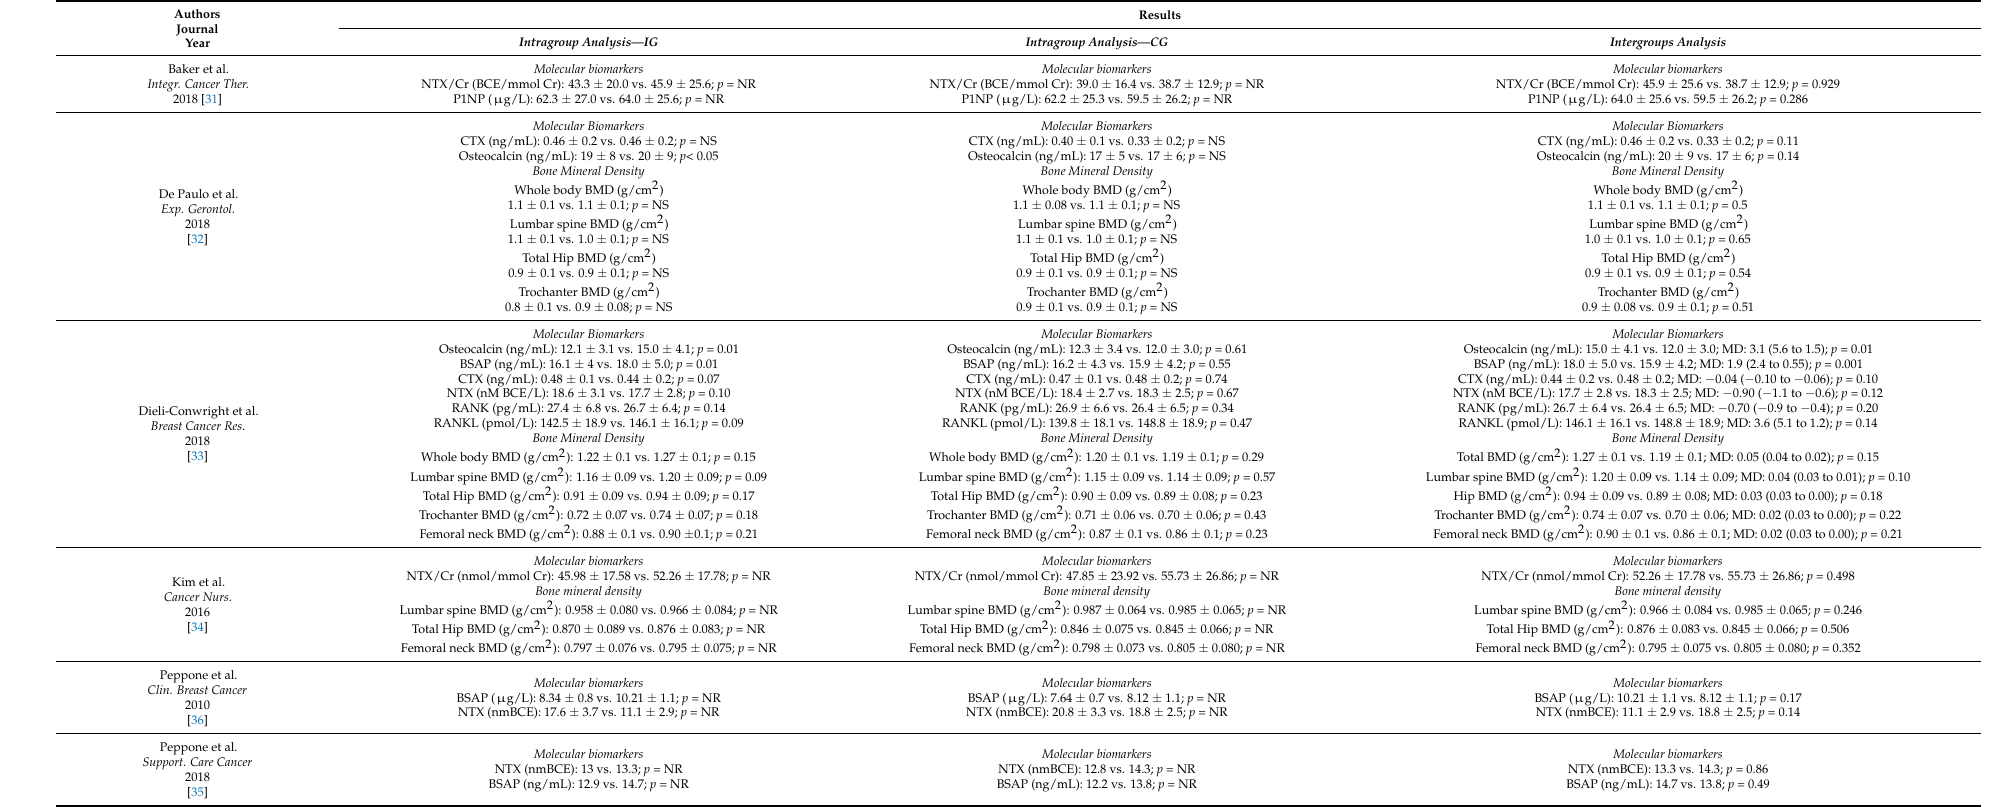
Table 4. Main results of the studies